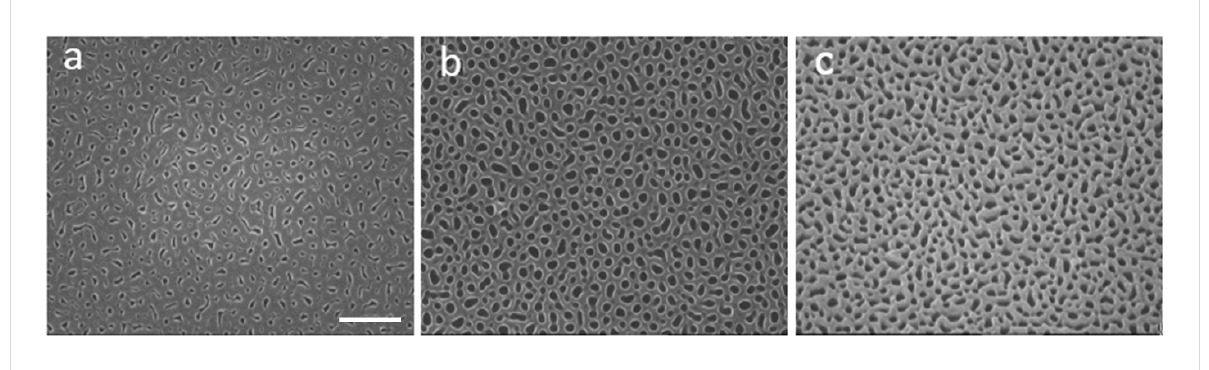
Figure 1: SEM images (20,000× magnification, scale bar 1 µm) of tAPA substrates (thickness ≈ 500 nm), a) as-prepared, b) after pore widening, and c) after 25 nm Au